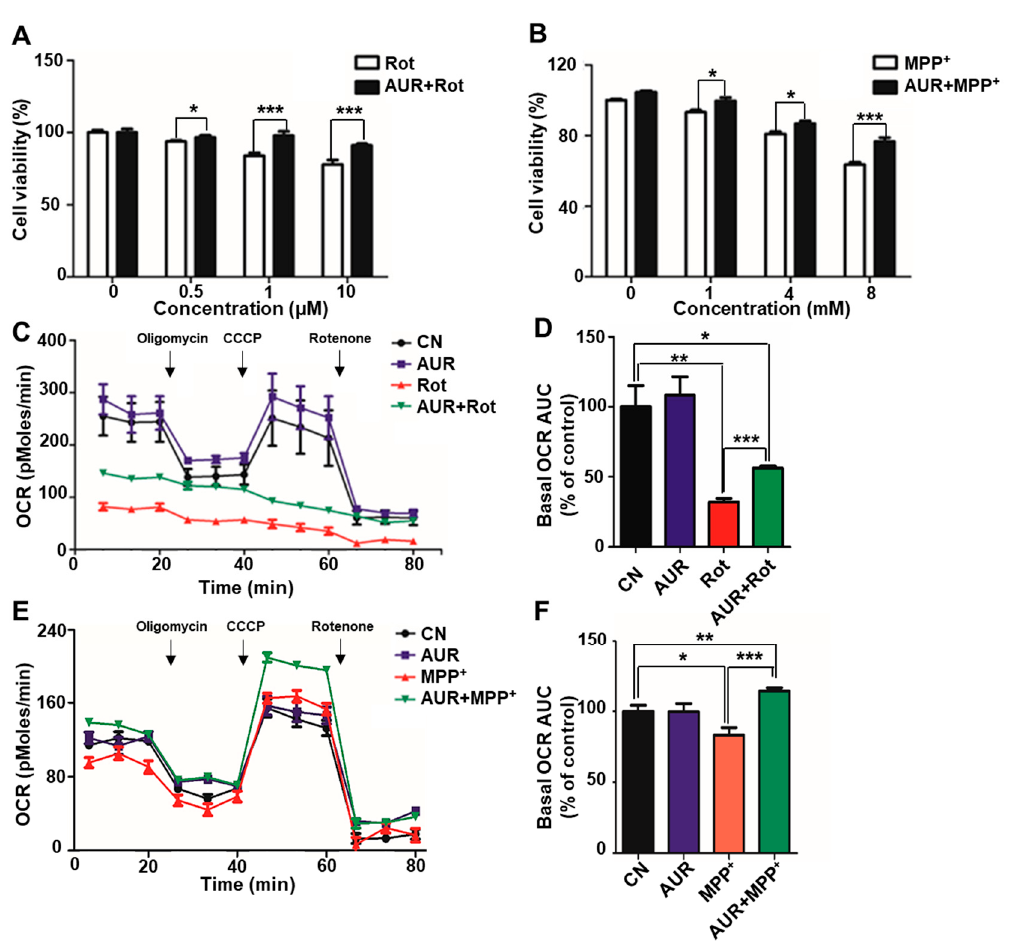
Figure 1. Auraptene (AUR) increases SN4741 cell viability and oxygen consumption rate (OCR) in the presence of neurotoxins. ( A , B ) SN4741 cells (5 × 10 3 ) plated in 96-well plates were incubated in media containing di ff erent concentrations (0, 0.5, 1 or 10 µ M) of rotenone (Rot) for 6 h or MPP + (0, 1, 4, or 8 mM) for 24 h in the presence or absence of AUR (1 µ M). Cell viability was measured by sulforhodamine B (SRB) assay after 6 or 24 h of drug treatment. ( C – F ), OCR was measured in SN4741 cells cultured with rotenone ( C , D ) or MPP + ( E , F ), with or without treatment with AUR. ( D , F ) Basal OCR area under the curve was calculated using XF24 analyzer software. Values are presented as means ± SD (bars) of triplicate samples (* P < 0.05, ** P < 0.01, *** P < 0.001 vs. corresponding controls). CN, control.